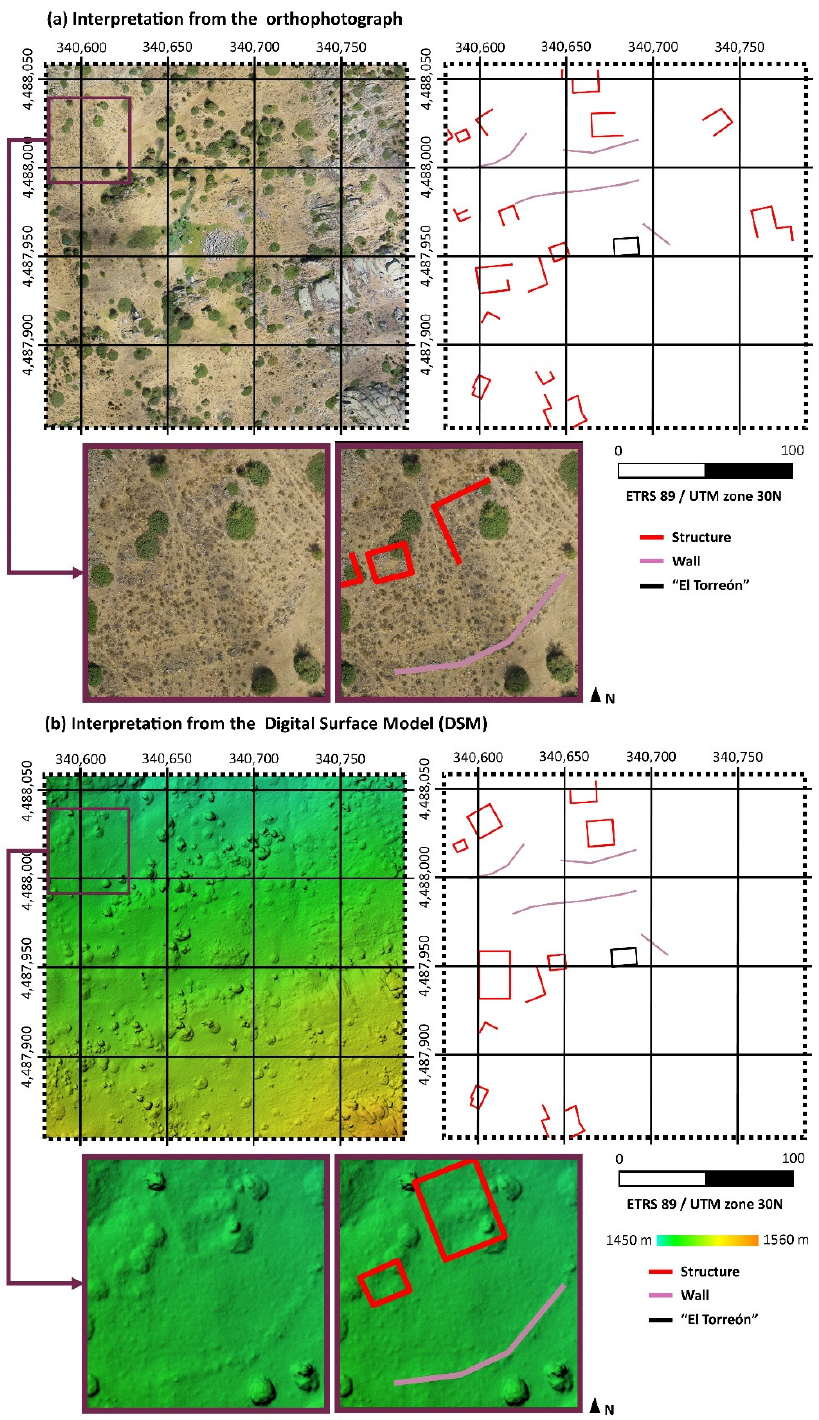
Figure 5. ( a ) Analysis of the orthophoto for the location of elements around “El Torreón”. ( b ) Analysis of the DSM for the location of elements in the area surrounding “El Torreón”.